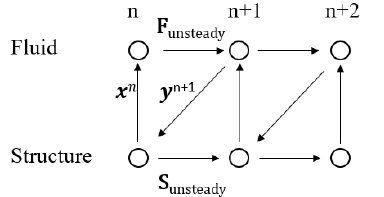
Figure 11. Schematic of the explicit coupling algorithm.